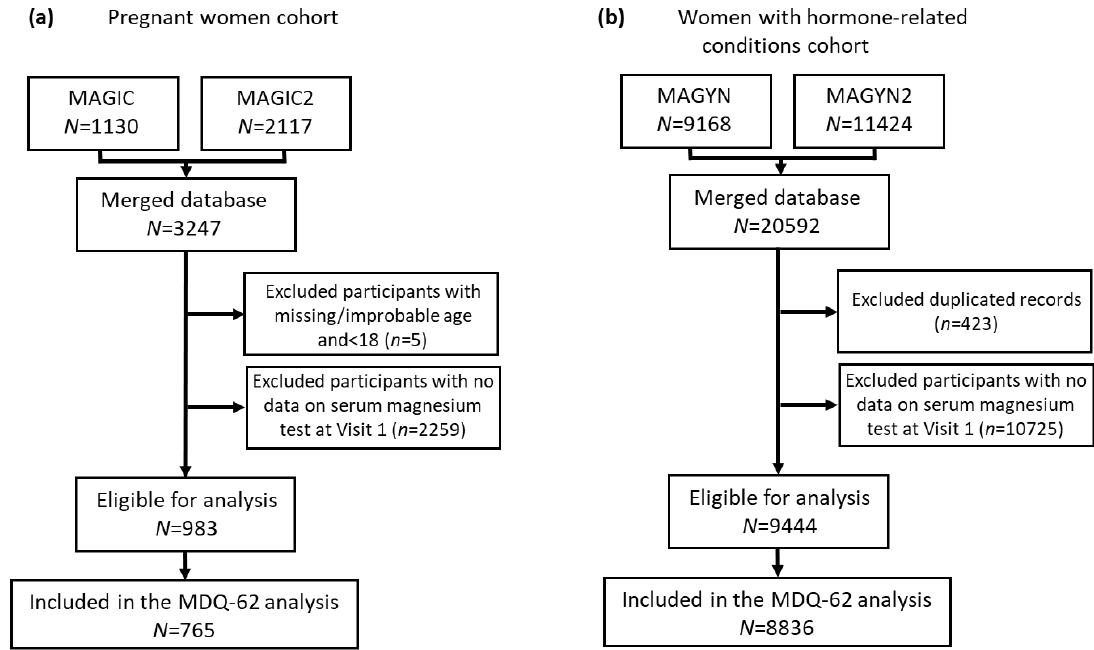
Figure 1. Study population: ( a ) Pregnant women cohort; ( b ) Women with hormone-related conditions cohort.